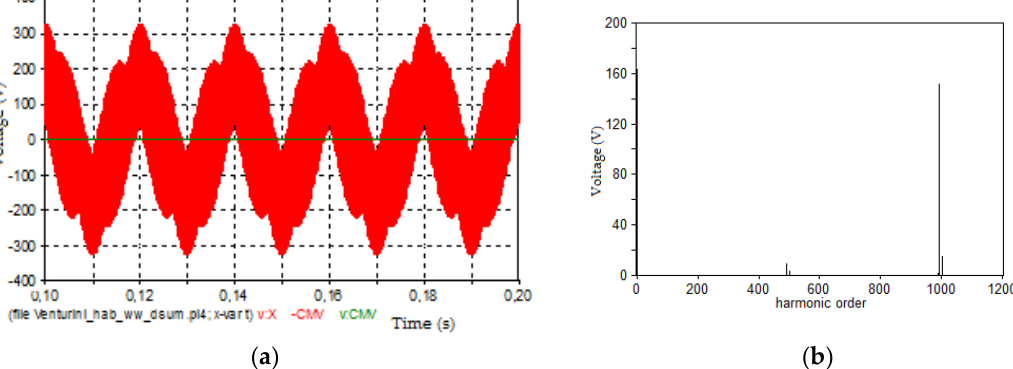
Figure 4. Waveforms of the output voltages (red lines) and CMV (green lines) ( a ) and Fourier analysis of the output voltage ( b ), synthesized in MMC and controlled by the use of CCW rotating space vectors, for the angle ψ = 0 ◦ and output frequency of 50 Hz.